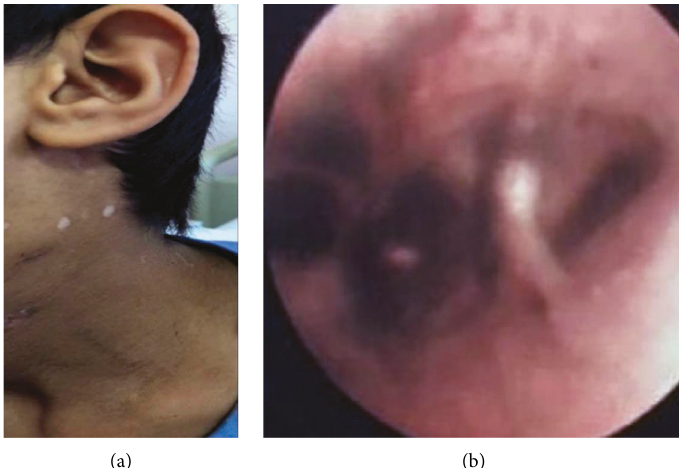
Figure 1: Left neck enlarged lymph nodes with healed scars (a) and flexible bronchoscopy (b) showing severe diffuse bronchitis with distal necrotic